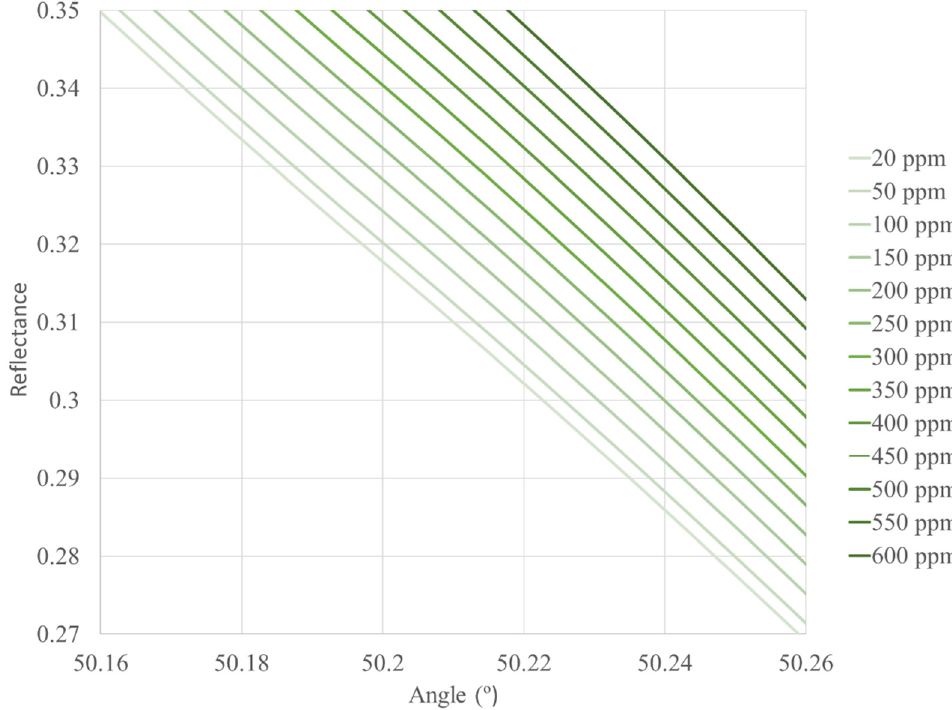
Figure 3. Reflectance curves as a function of the angle of incidence of the light in the hemispherical prism and different concentrations of CO. The height above sea level is 1500 m, 8.45 × 10 7 Pa, 16 °C. The sensor works with an incidence angle of 50.20°.